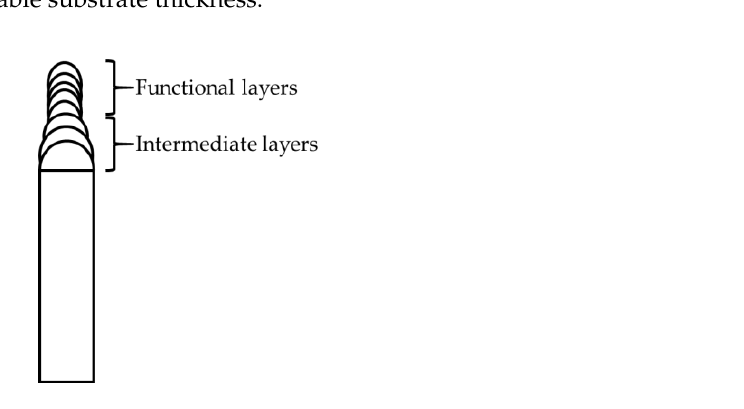
Figure 15. Building up of intermediate layers to get target layer width from a wider substrate.